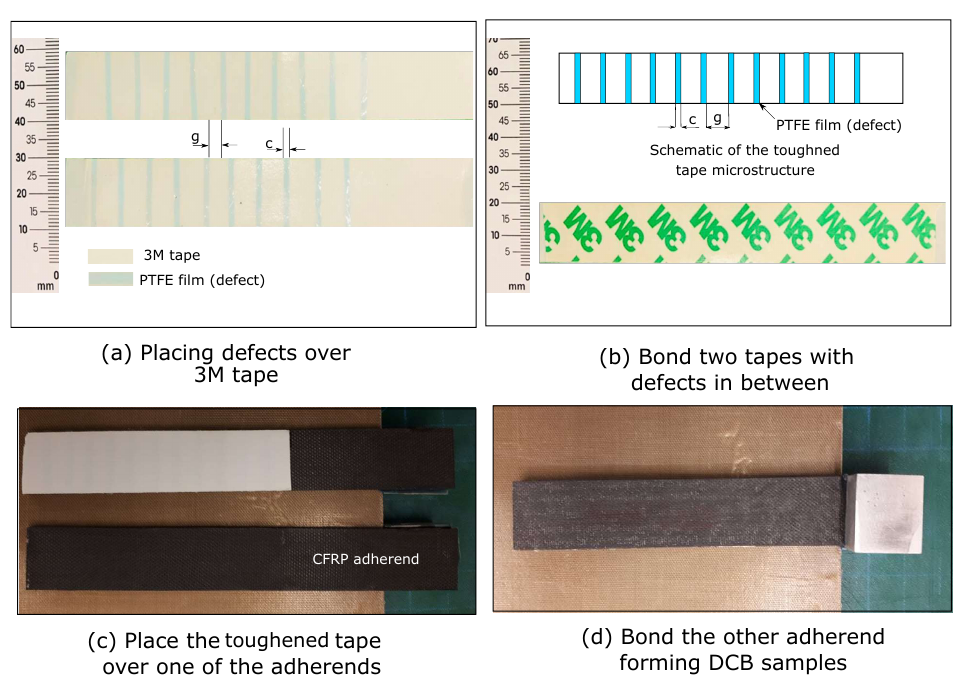
Figure 1. Manufacturing toughened thermoplastic tapes and bonding DCB